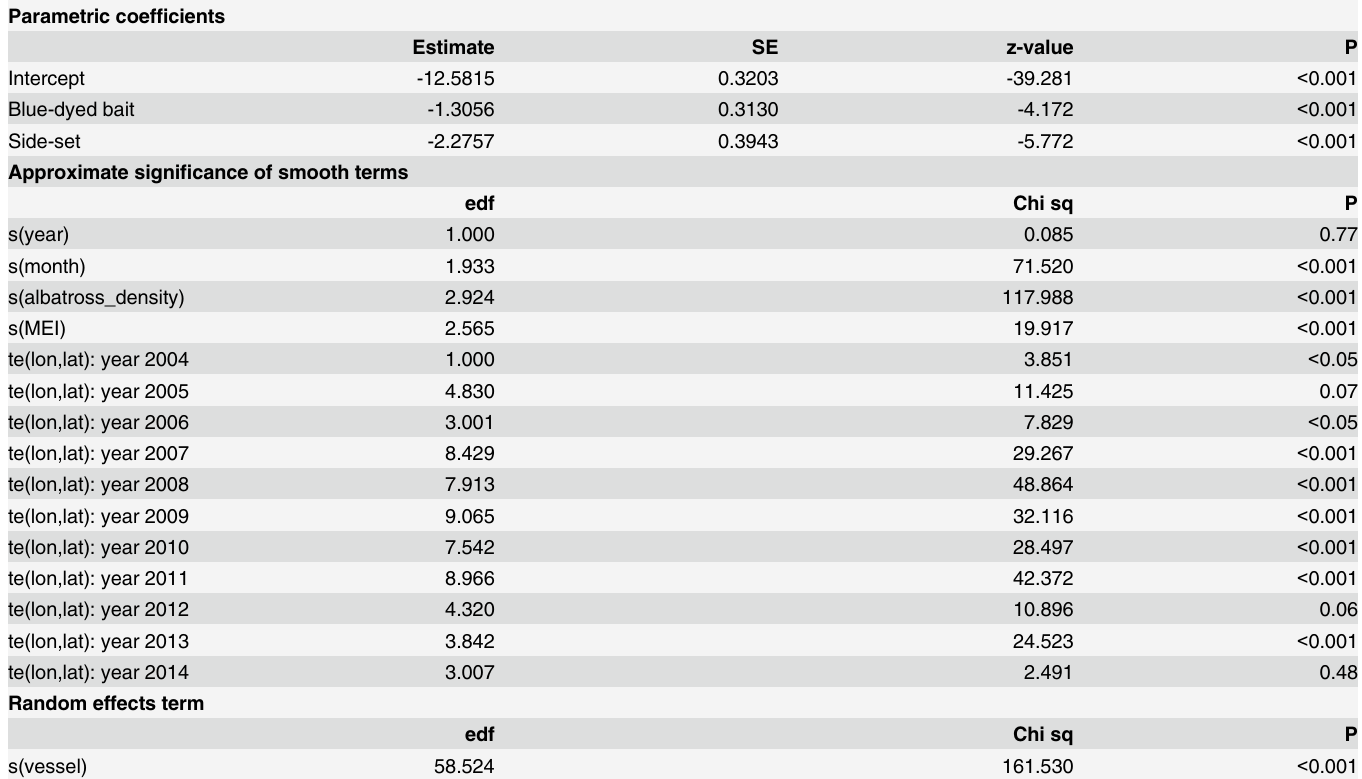
Table 2. Summary of geoadditive GAMM fit to seabird catch data, Hawaii longline tuna fishery, 2004 – 2015. edf = effective degrees of freedom, te() = tensor product, s() = nonparametric smoother. Model terms are defined in the methods section. Parametric coef fi